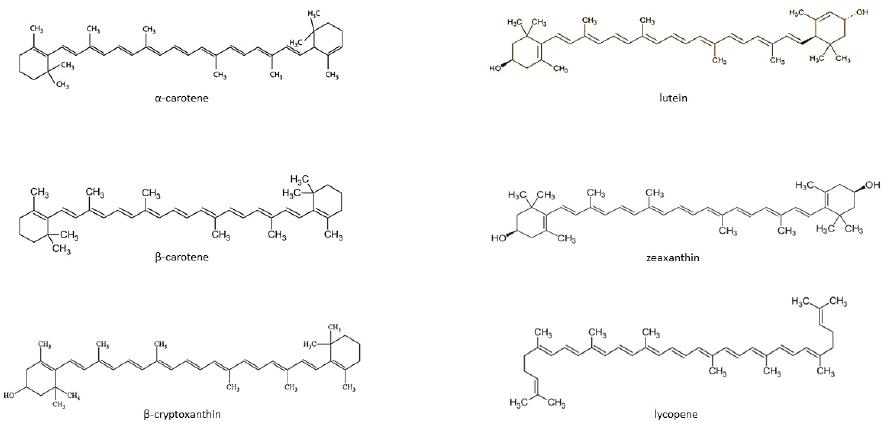
Figure 1. Chemical structure of some common carotenoids [133–138]. Source: Own elaboration based on the indicated data.